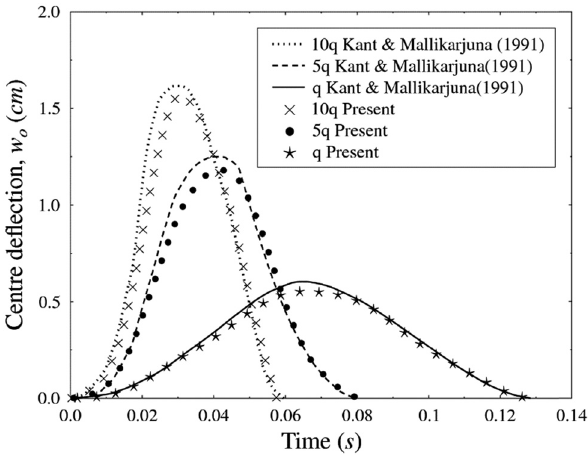
Figure 4: Comparison of nonlinear transient responses of isotropic square plates under suddenly applied uniformly distributed pulse loading.